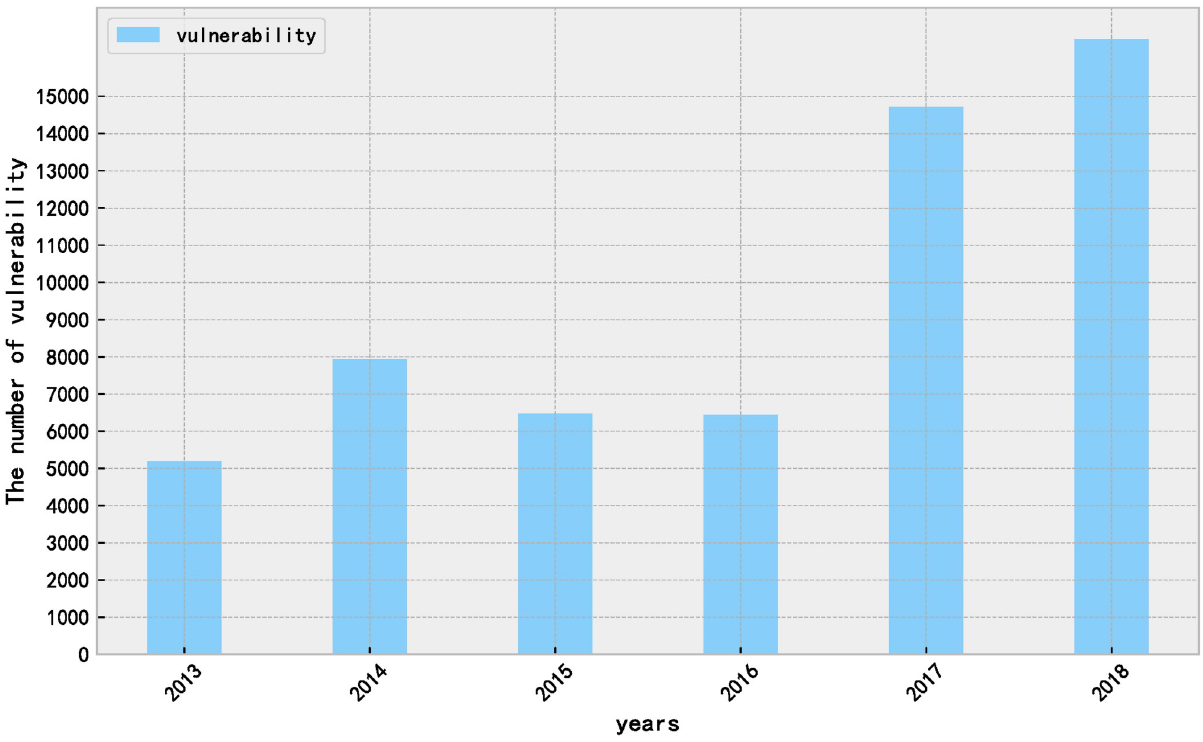
Fig 2. Vulnerability disclosures added to the National Vulnerability Database (NVD) by